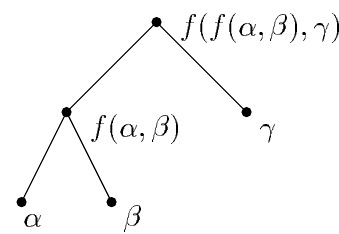
Fig. 3: An example of synthetic